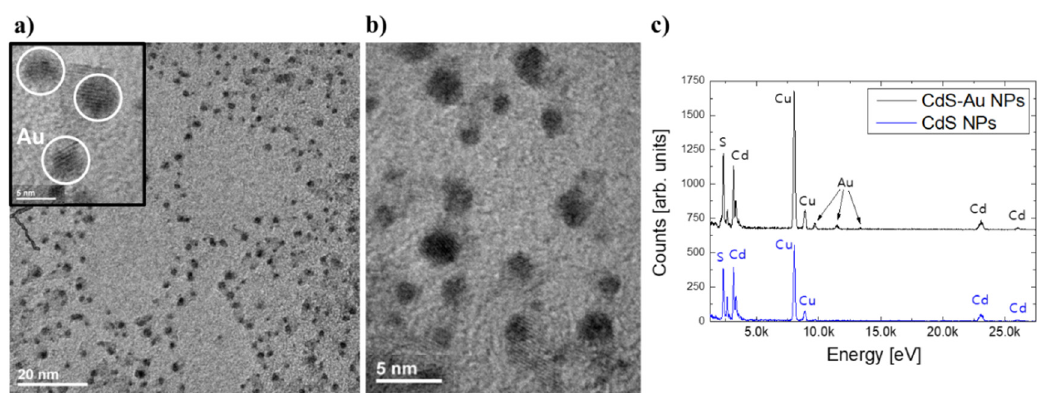
Figure 1. Representative transmission electron microscopy (TEM) and HRTEM images ( a , b ) of CdS-5Au nanoparticles (NPs), together with EDX spectrum ( c ) obtained for as-synthesized CdS NPs and CdS-Au hybrid structures. Au nanostructures are visible as the darkest regions (marked in the inset in a with white circles), while CdS tetrapod-shape NPs are more pale owing to the significantly higher density of Au in comparison with CdS.